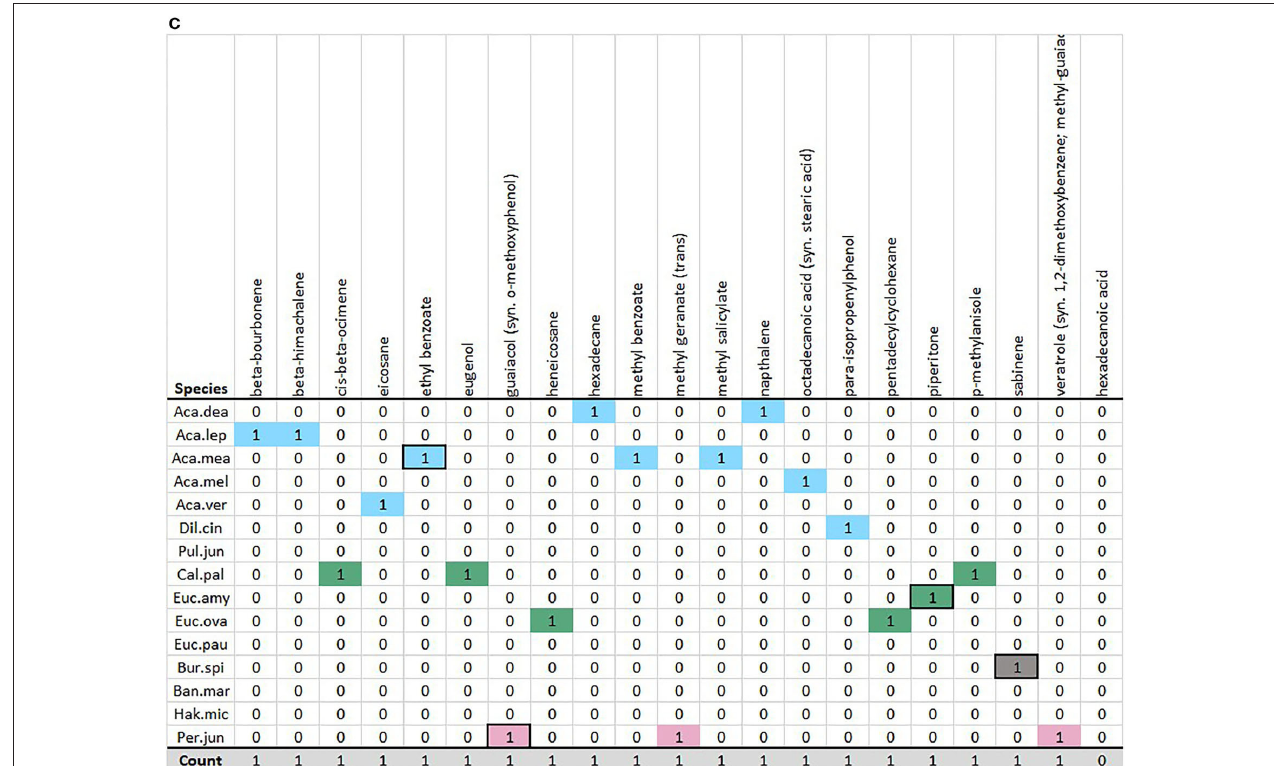
FIGURE 3 | (A) Color matrix of dominant floral peaks, Part A. Rows are colored by family, columns sorted by most to least commonly occurring (left to right), and alphabetically. Black box outlines indicate the “Top 2” (highest emission) peaks per species. (B) Color matrix of dominant floral peaks, Part B. Rows are colored by family, columns sorted by most to least commonly occurring (left to right) and alphabetically. Black box outlines indicate the “Top 2” (highest emission) peaks per species. (C) Color matrix of dominant floral peaks, Part C. Rows are colored by family, columns sorted by most to least commonly occurring (left to right) and alphabetically. Black box outlines indicate the “Top 2” (highest emission) peaks per